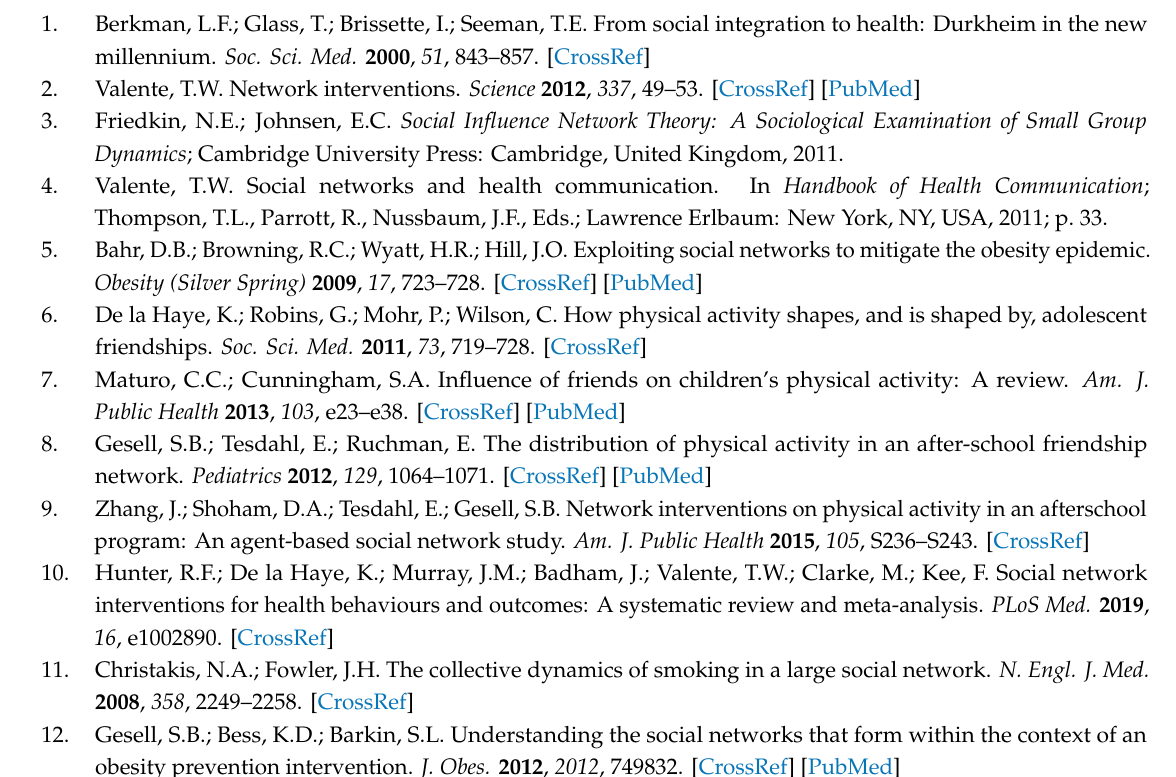
Figure S1: Conceptual Model: How social networks a ff ect health, File S1: Network Statistics, File S2: Multivariate Hidden Markov Models, Table S1: Goodness-of-fit (BIC) values from the multivariate hidden Markov Model analysis, File S3: Network States, Table S2: Classification of state patterns into network